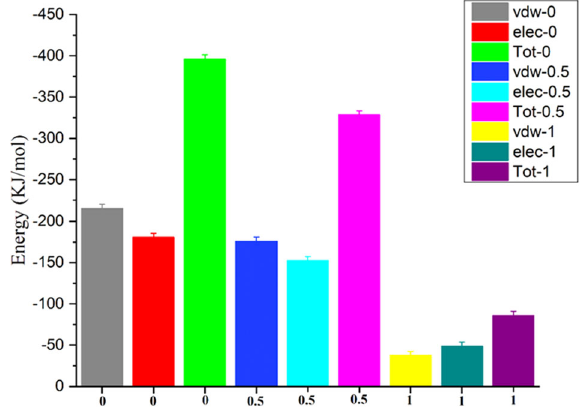
Table 2. The electrostatic (Elec), van der Waals (vdW), and total energies (in kJ mol − 1 ) between the phenol molecules and the COFs nano-channel in various systems.